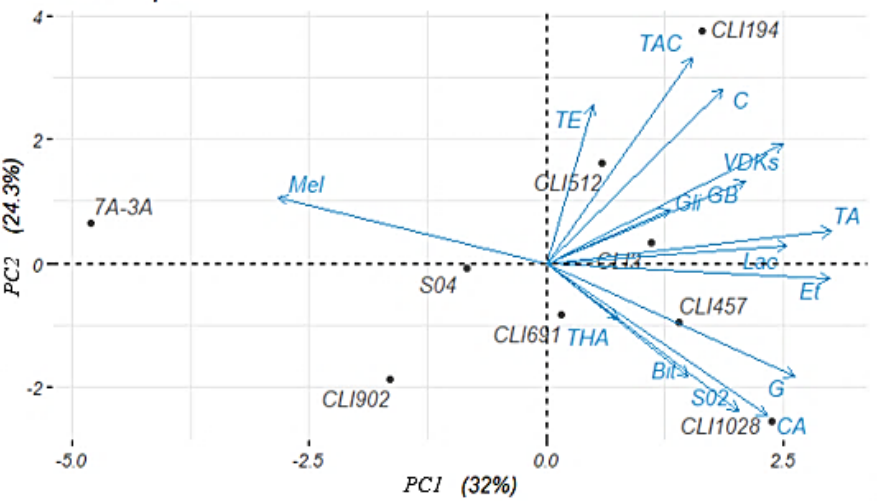
Figure 5. PCA-biplot of the beers fermented sequentially and the different parameters analysed. Each beer is the average of three samples. Mel, melatonin; Bit, bitterness; GB, γ -butyrolactone; Gli, glycerol; CA, antioxidant capacity; Et, ethanol; TA, total fatty acids; THA, total higher alcohols; TE, total esters; TAC, total aldehydes/ketones; Lac, lactic acid; G, guaiacol; C, colour.